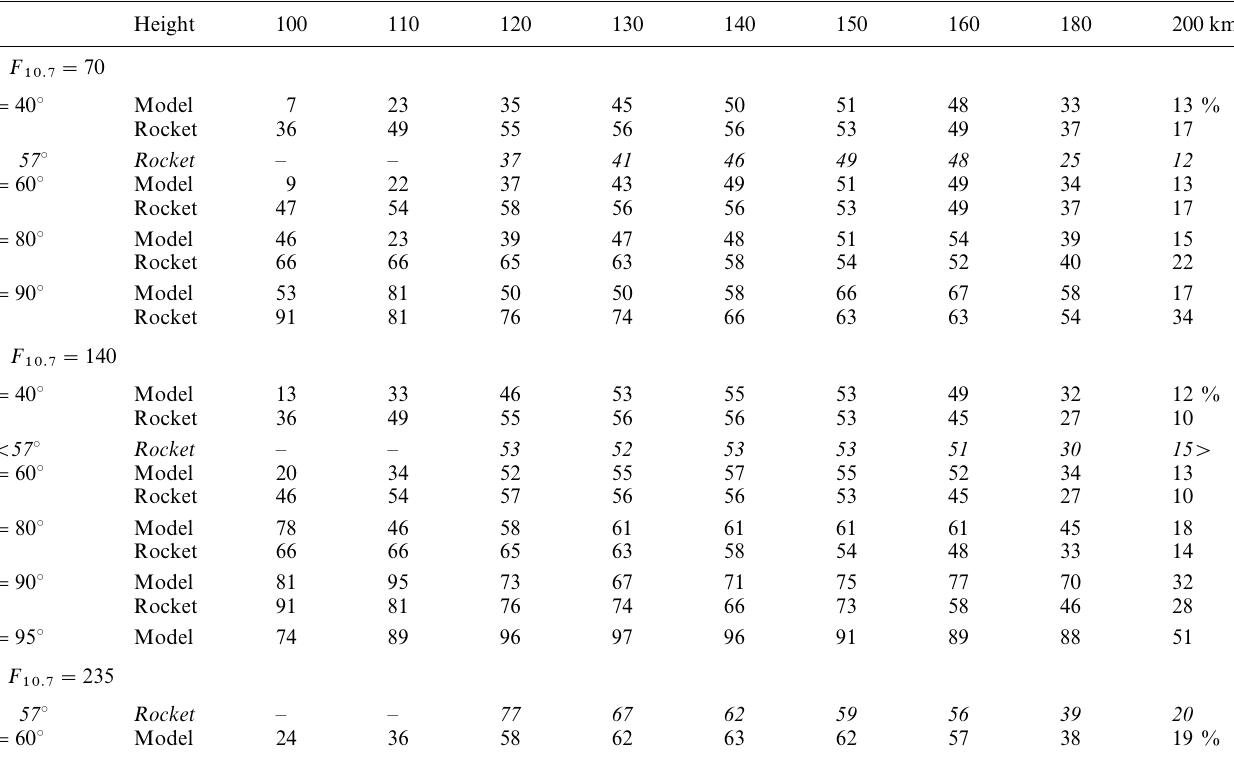
Table 1. The percentage of NO (cid:96) ions at heights from 100 to 200 km, from the present Model calculations at a latitude of 40 ° N, and from mean Rocket results tabulated by Danilov and Semenov (1978). Values in italics are from rocket data analysed by Mitra and Benerjee (1971) Height